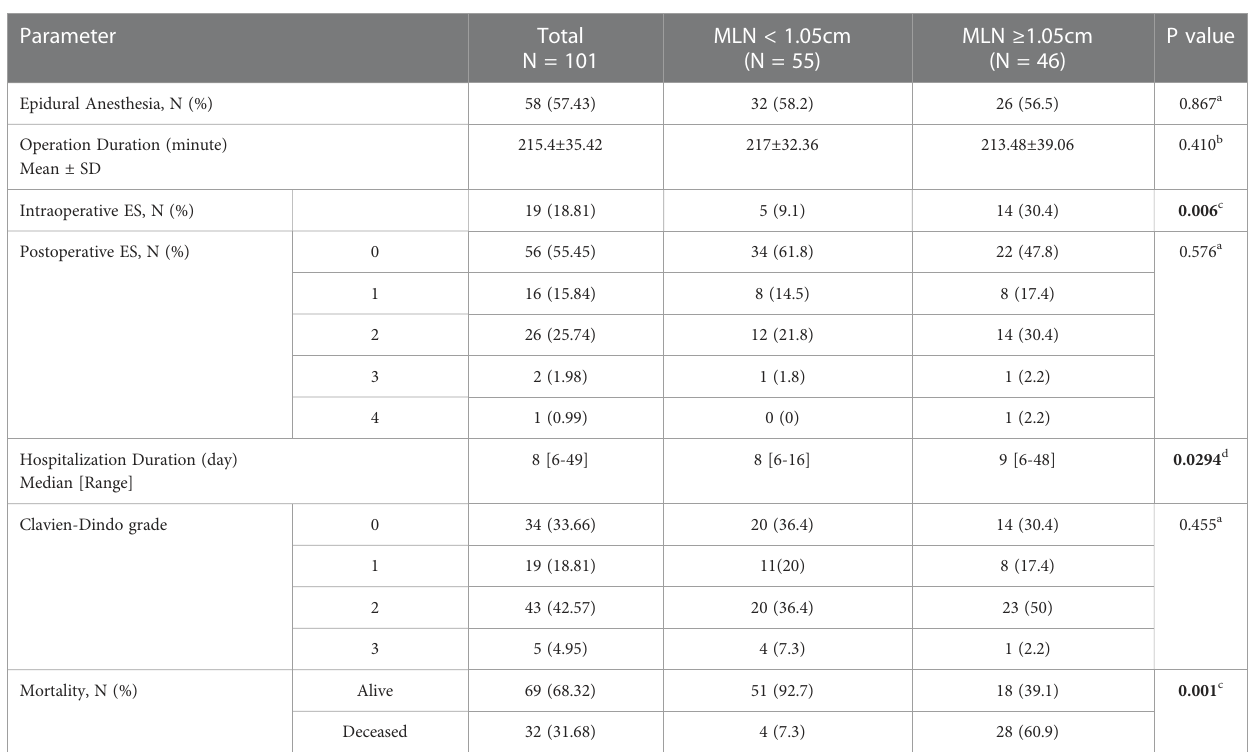
TABLE 7 Intraoperative and postoperative fi ndings.